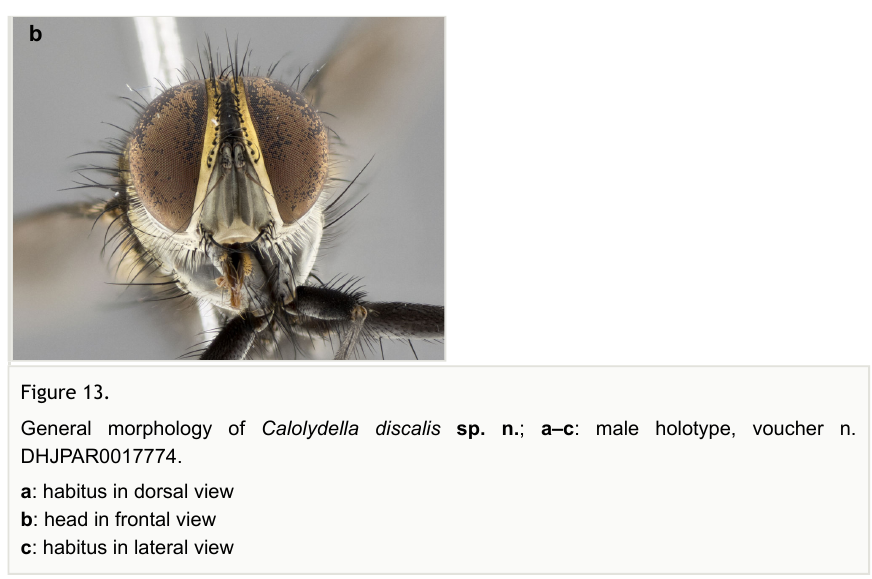
silver ventrally, and with an orange spot lateroventrally at base of ST1+2; T3 with one pair of median marginal setae pair and two pairs of discal setae; T4 with two pairs of discal setae. Terminalia (Fig. 14): sternite 5 (Fig. 14c) with two small lobes and a wide U-shaped median cleft, 0.37X the length of the sternite from lobe to apex; inner margin covered by dense pollinosity, appearing darker than surrounding cuticle; entire lobe of sternite covered with short setae, all of equal length. Cerci (Fig. 14b), in dorsal view, narrow and tapered, separated by a narrow gap widening at apex; cercus long, slender and straight when viewed laterally, very slightly tapered from its already narrow base; setose along its basal half. Surstylus (Fig. 14a) subequal to length to cercus, slender and digitiform when viewed laterally; with short setae along entire length; tip of surstylus not curved inwards when viewed dorsally.